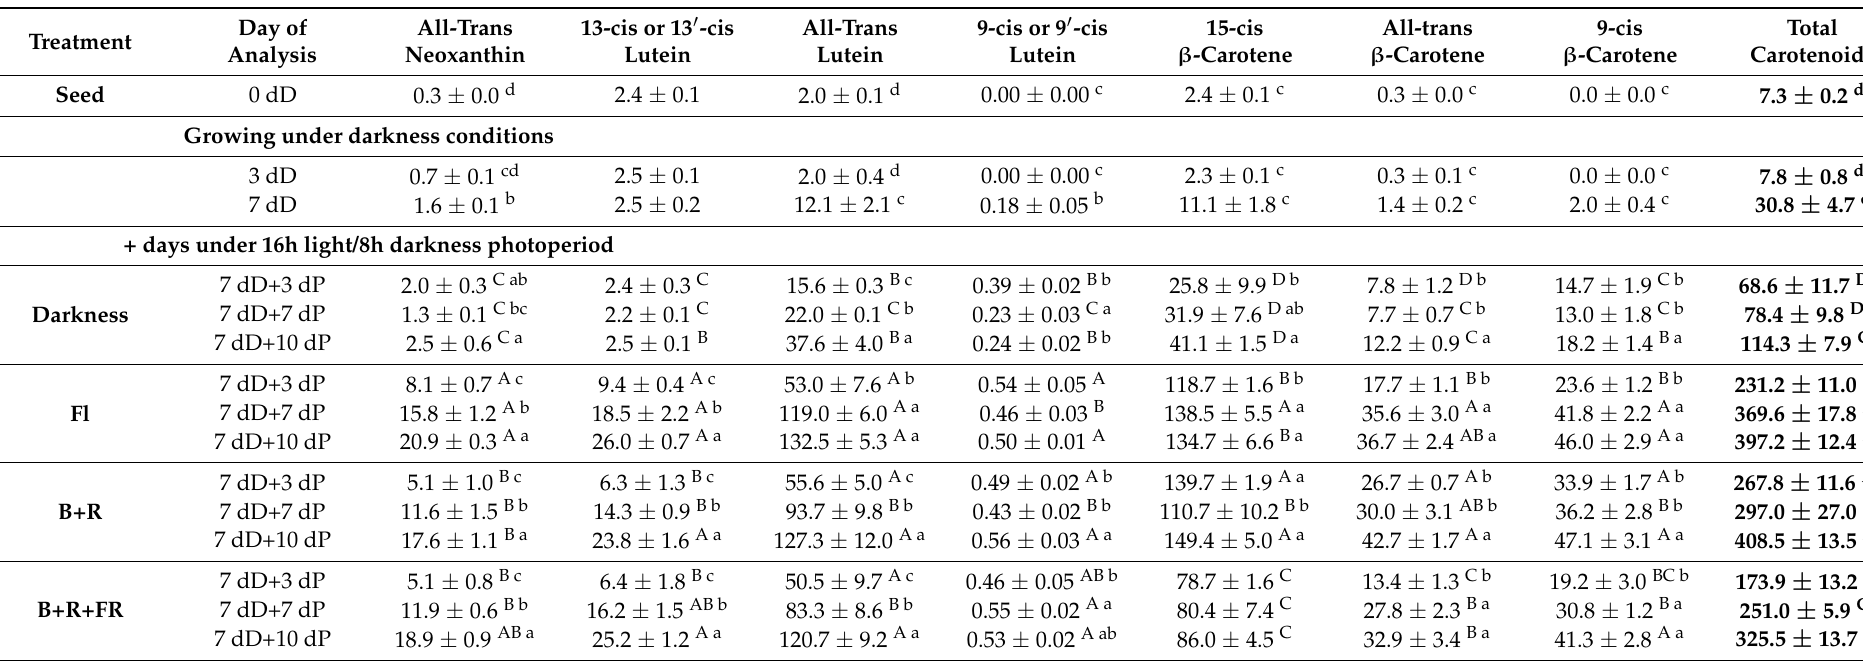
Table 4. Carotenoid content (mg kg − 1 dw) of carrot sprouts grown at 20 ◦ C during 7 days in darkness (dD)+3 or 7 or 10 days of a 16 h/8 h photoperiod (dP) under several light treatments. Day of All-Trans 13-cis or 13 (cid:48) -cis Treatment Analysis Neoxanthin Lutein